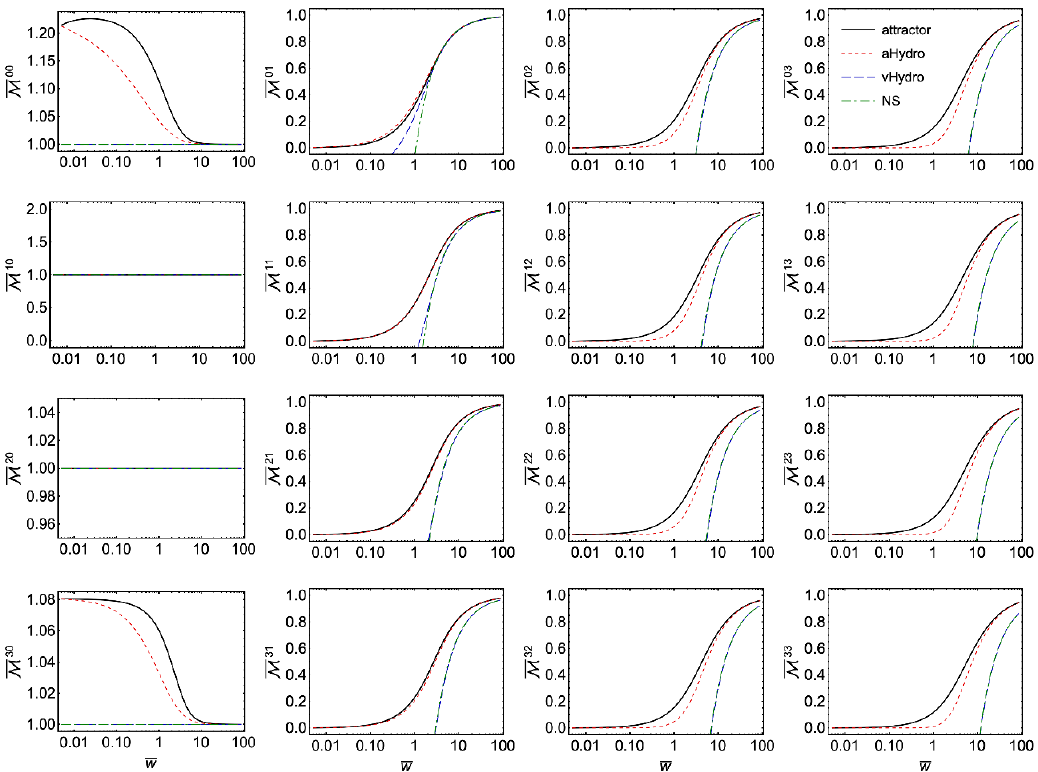
Figure 5 . Scaled moments M nm obtained from the exact attractor solution (solid black line) compared with the aHydro attractor (red dashed lines), DNMR attractor (blue long dashed lines), and the Navier-Stokes limit for each moment (green dot-dashed lines). Horizontal axis is (cid:22) w (cid:17) (cid:28)T= 5(cid:22) (cid:17) . Panels show a grid in n and m